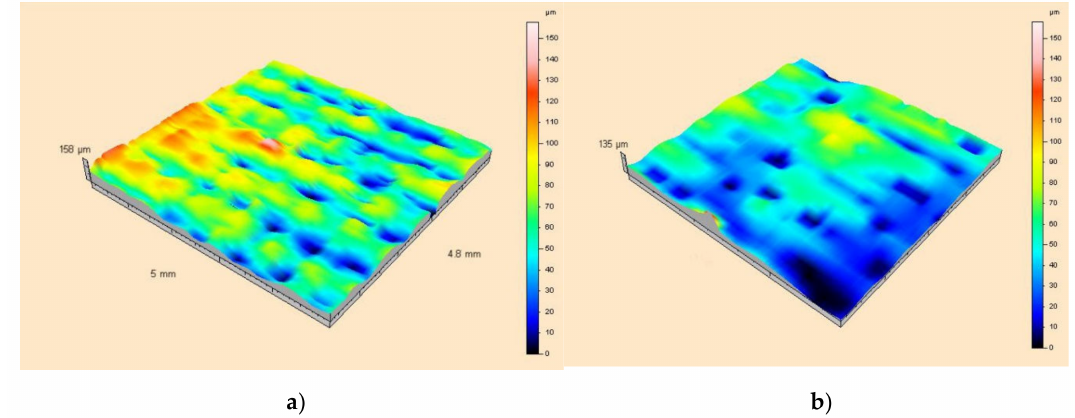
Figure 12. Primary profile ( a ) for the composite surface, ( b ) for the applied coating.